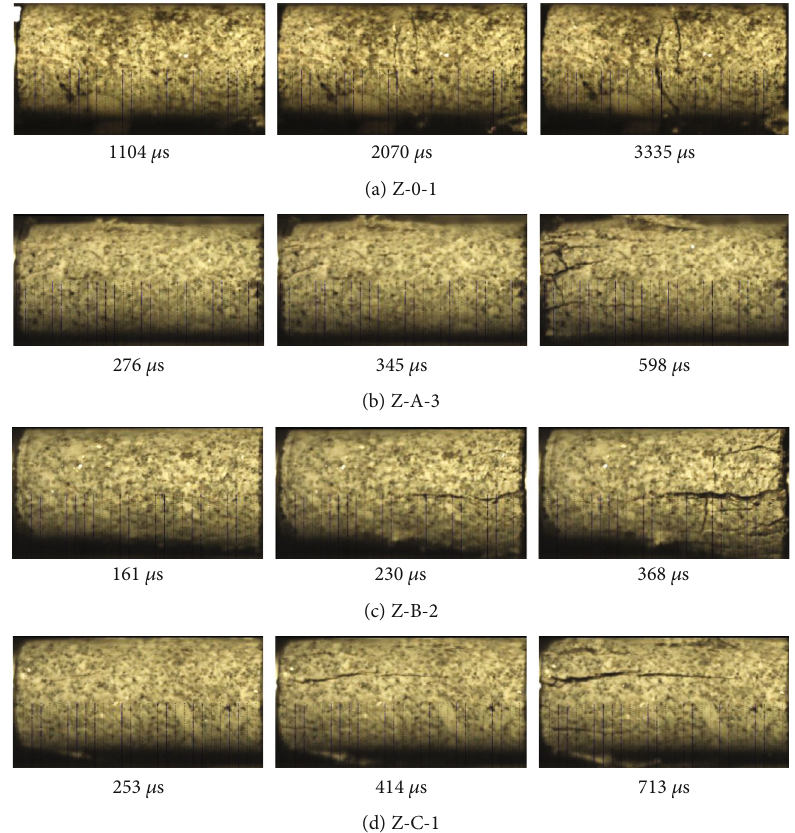
Figure 12: Failure process diagram of di ff erent axial prestress loads.